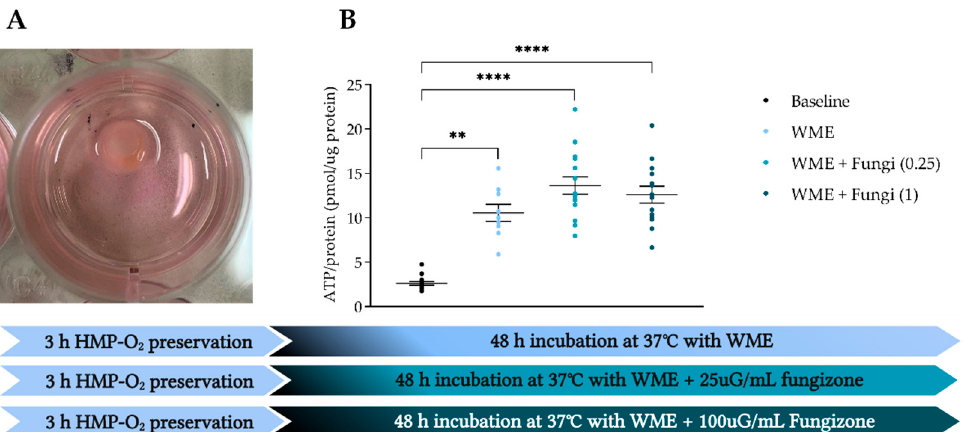
Figure 6. The addition of Amphotericin B (fungizone) to prevent fungal infections. ( A ) PCKS with a fungal infection by Candida guilliermondii . ( B ) Porcine kidneys were preserved with HMP, sliced at baseline ( • ) ( n = 6), and incubated in WME ( • ) ( n = 7) with 25 µ g/mL fungizone ( • ) ( n = 15) or 100 µ g/mL fungizone ( • ) ( n = 15) for 48 h. ** p < 0.01, **** p < 0.0001. WIT, warm ischemia time; ATP, adenosine triphosphate. The data are shown as mean ± SEM.